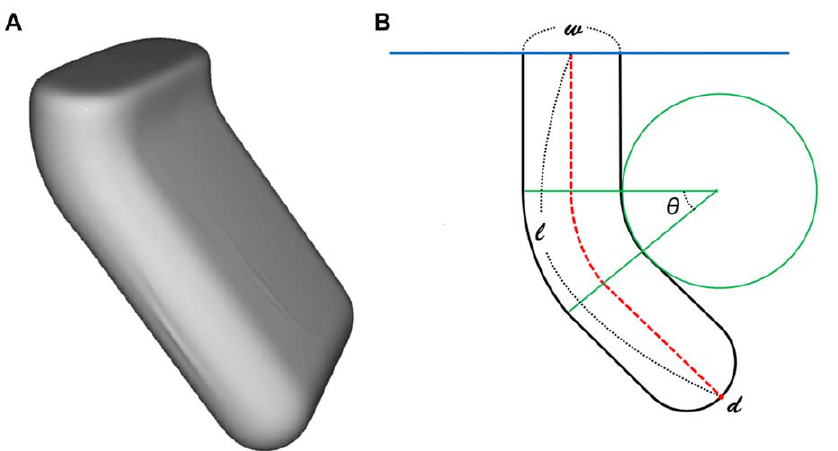
Figure 4. Extracted simulation data using the modified CLASP algorithm (A), and its diagram (B). The components managing the morphometry of the simulation data are shown in (B). w is sulcal width; h is the folding degree from an outside point located on a line parallel to the seed of distance (blue line); and l is the length of the medial line (red dotted line) with its end point defined as the deepest point ( d ).